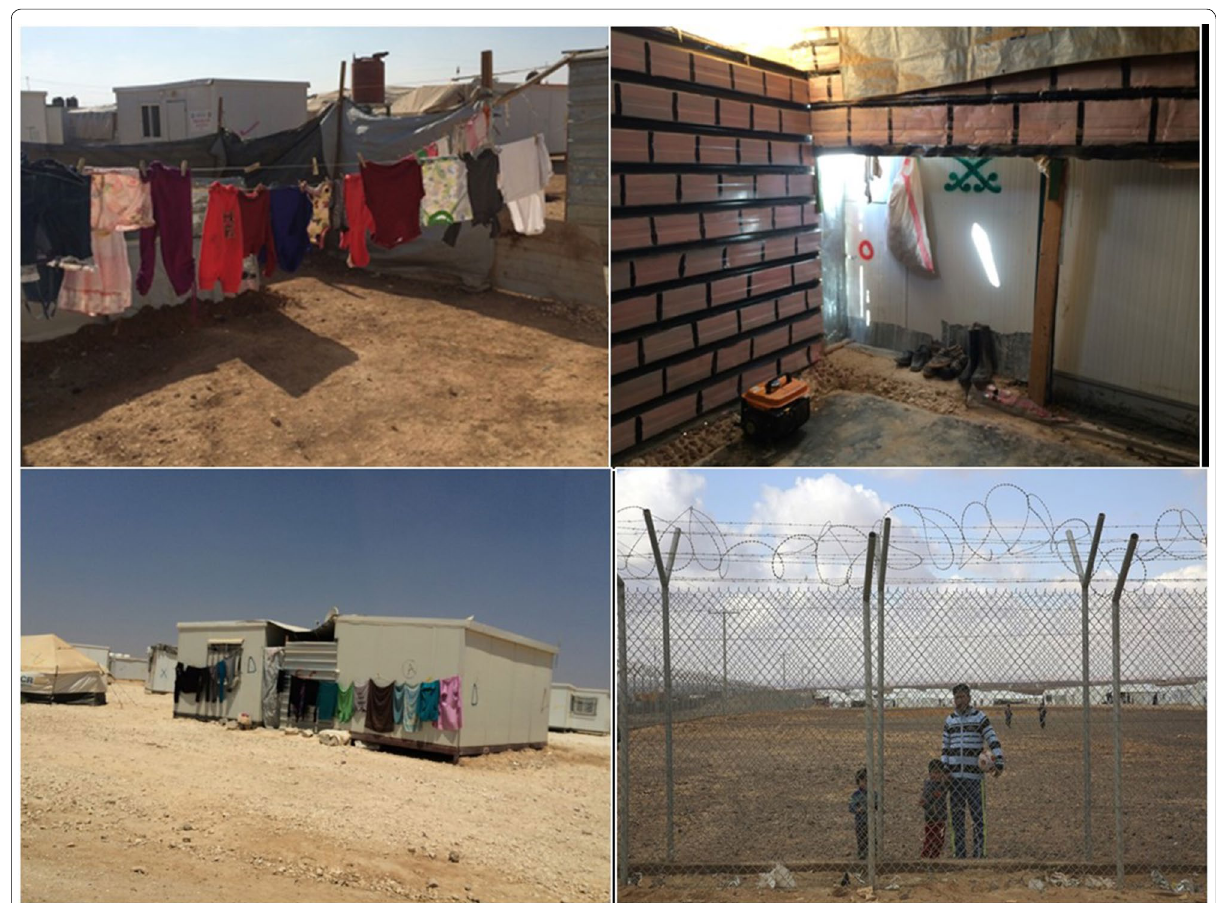
Fig. 3 (Top) informal layout in the Al Za’atari camp (Source: Authors’ photo), (bottom left) Prefabricated shelters in the Al Za’atari camp (Source: http://www.googl e.jo), (bottom right) Al Azreq camp in Jordan (Source:http://www.apnew s, 2018)